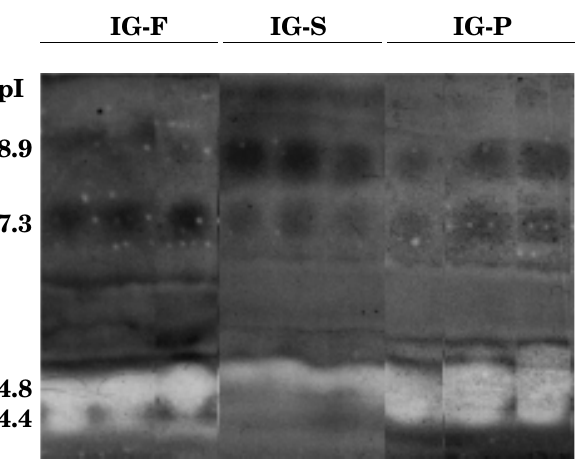
Fig. 5. Isoelectric focusing (IEF) zymograms of pectin lyase and pectin methylesterase produced by different isolates of the intersterile groups (IGs) F, S and P of Heterobasidion annosum on day 16 from inoculation in a liquid medium with pectin as the sole carbon source. Samples (2 ml of 50-fold concentrated culture filtrate) were separated by broad-range analytical IEF. PNL and PME activities, detected by the activity stain overlay technique at pH 8, appear as white and dark red bands respectively. The pI values of bands are indicated on the